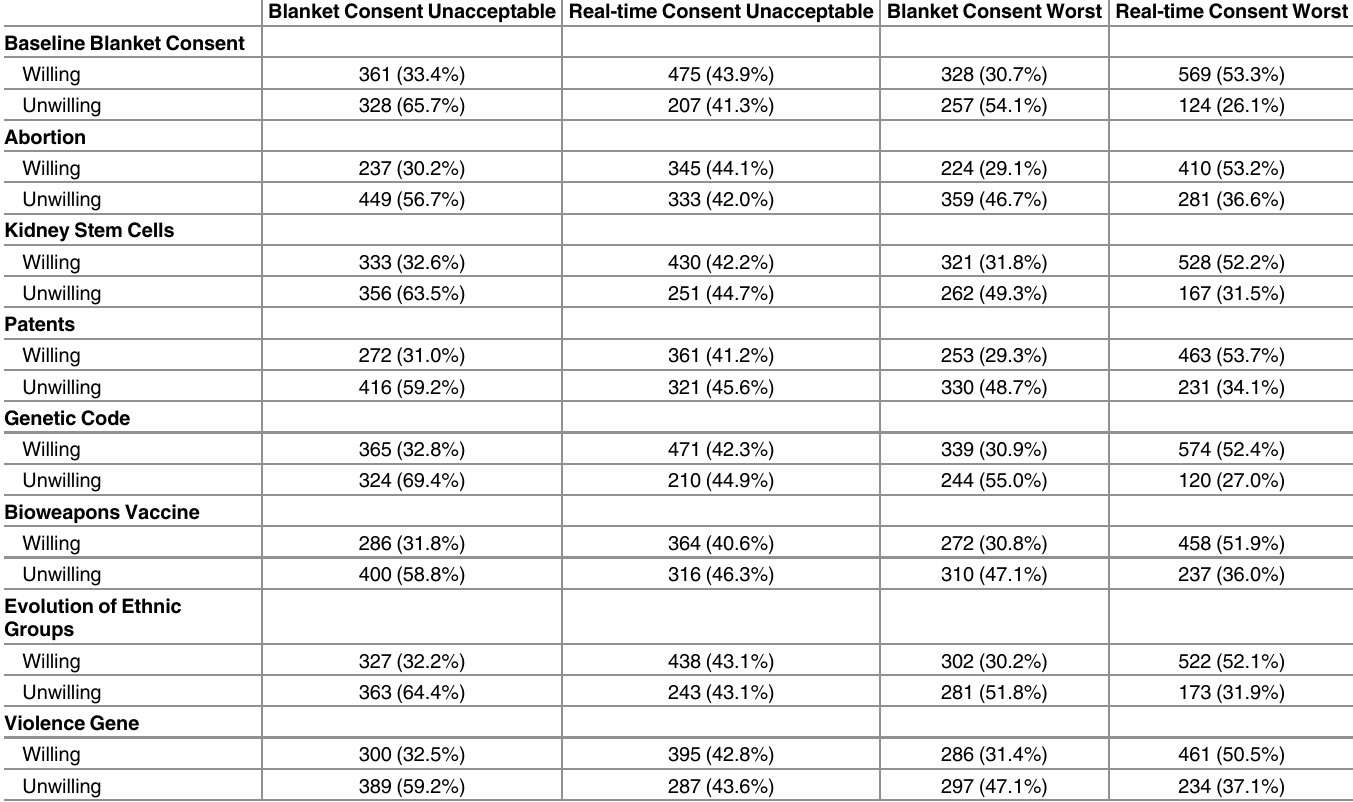
Table 5. Consent policy preferences by willingness to donate using blanket consent in different types of NWI scenarios and in baseline blanket consent.